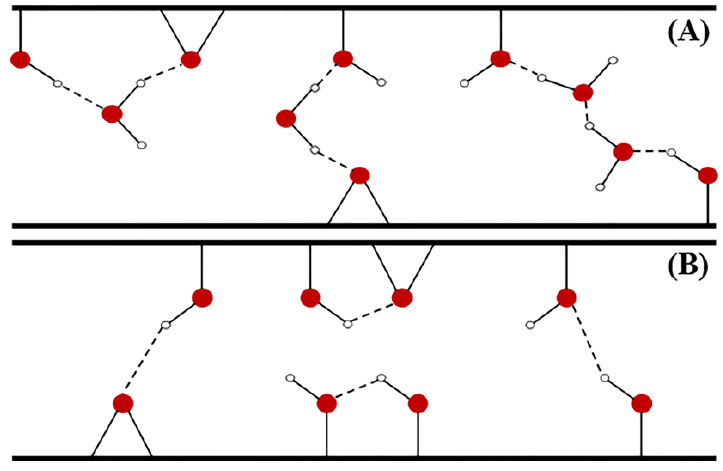
Figure 11. Hydrogen bonding: ( A ) OCFGs–H 2 O; and ( B ) OCFGs–OCFGs.